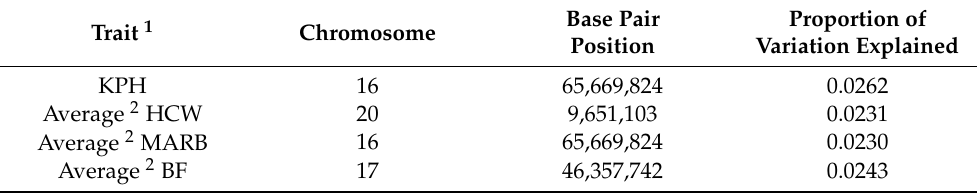
Table 2. Genetic correlations and standard errors between carcass and maternal traits 1